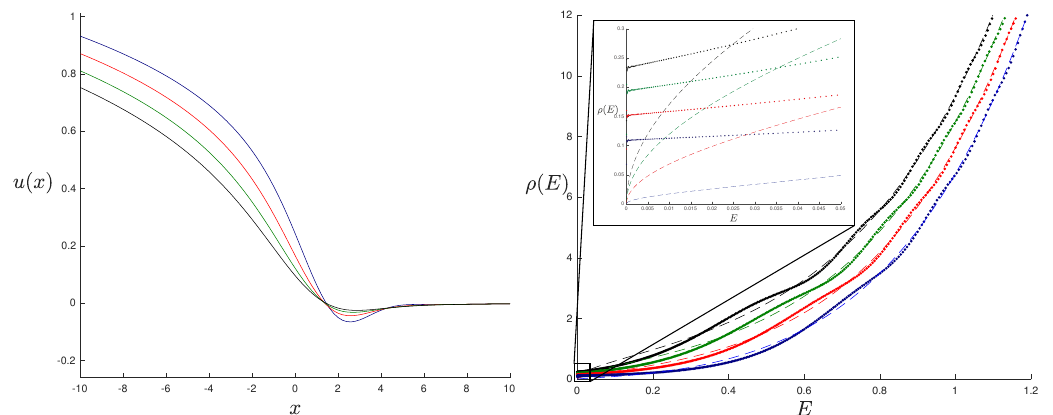
Figure 7. On the left are plots of the non-perturbative potential u ( x ) obtained from numerically solving (2.15) for ( α 1 , α 2 ) = (1 / 4 , 1 / 3) with λ = 0 (blue), λ = − 10 / 3 (red), λ = − 20 / 3 (green) and λ = − 10 (black). On the right are the associated spectral densities obtained from equation (2.6) and plotted using the same colours, with the dashed lines corresponding to the disc spectral density ρ 0 ( E ) in